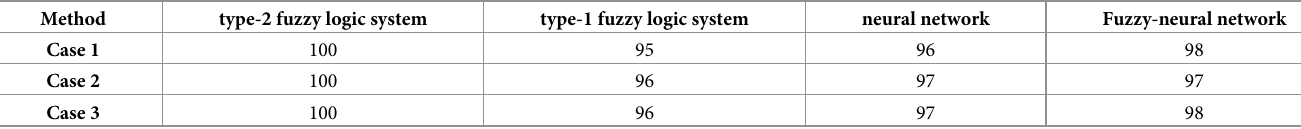
Table 5. Comparison of percentage of detection by different methods in scenario 2.